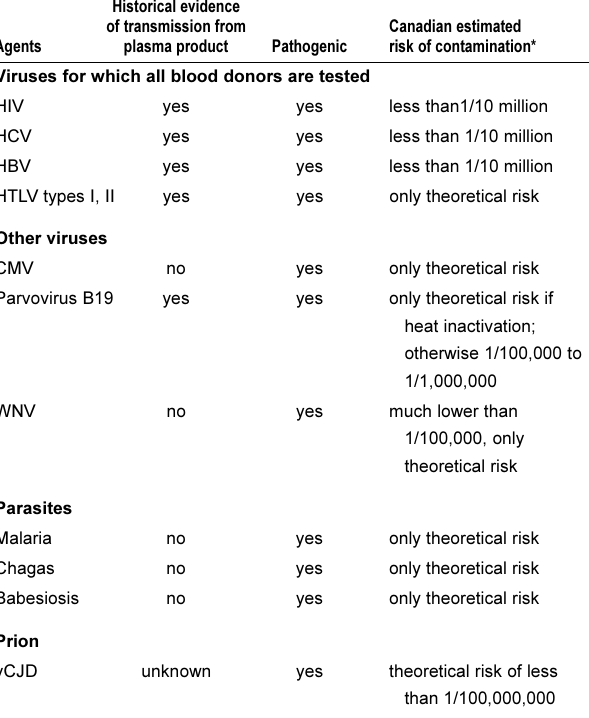
TABLE 5 Estimated risk of infectious agent blood or blood products Agents and Transfusion- Canadian estimated products